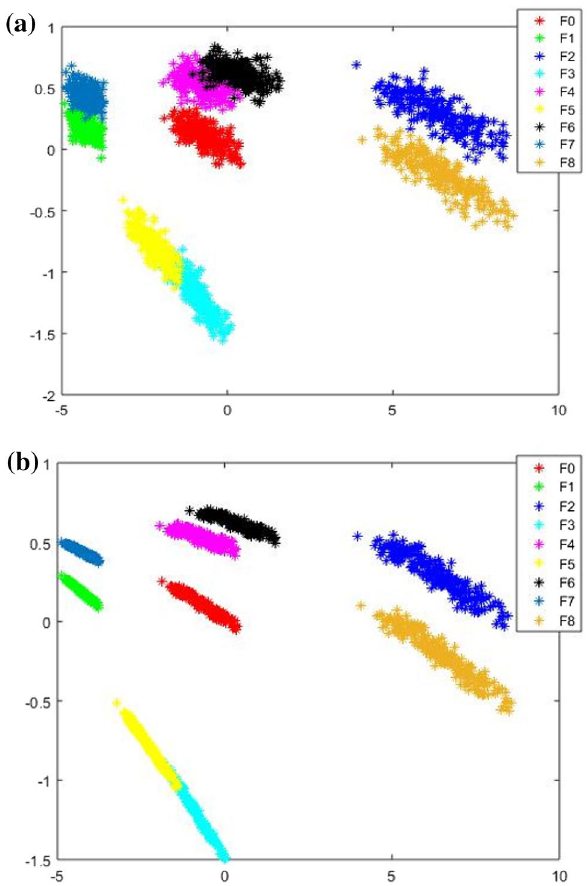
Figure 6. Characteristic distribution diagram of Case 2: ( a ) row data; ( b ) data after DBN feature